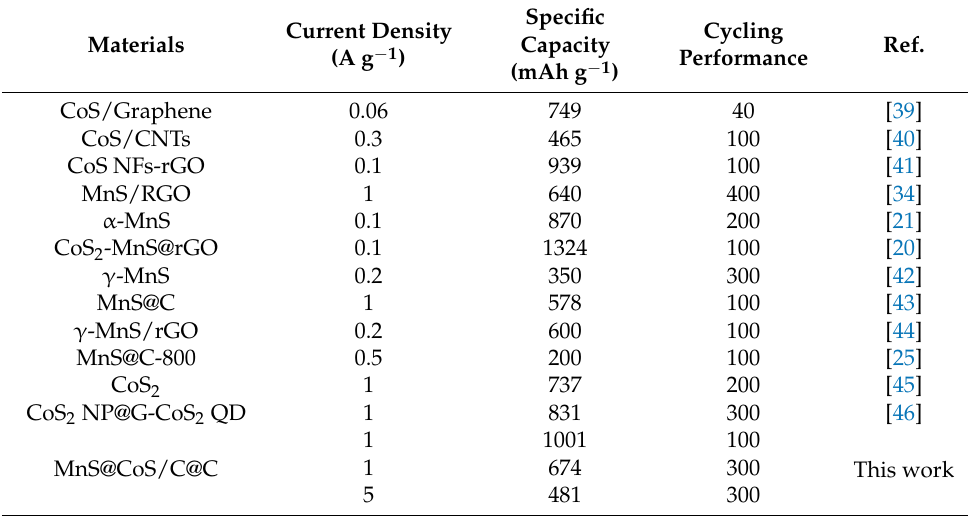
Table 1. Cycling performance comparison between MnS@CoS/C@C and other reported MnS, CoS composites.